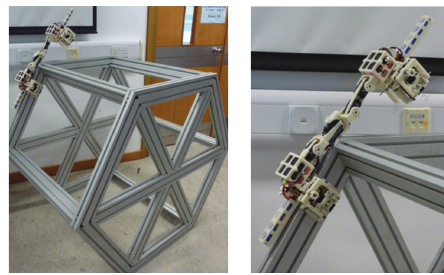
Figure 1: The prototype of